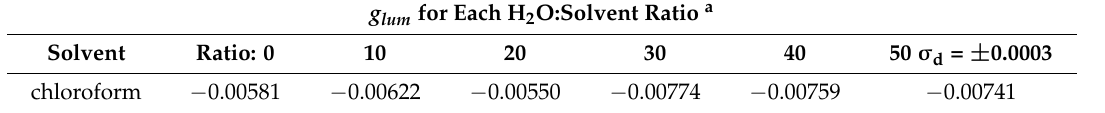
Table 7. Luminescence dissymmetry ratio values ( g lum ) for [Tb(DPA) 3 ] 3 − with varying ratios of H 2 O:chloroform. g lum for Each H 2 O:Solvent Ratio a